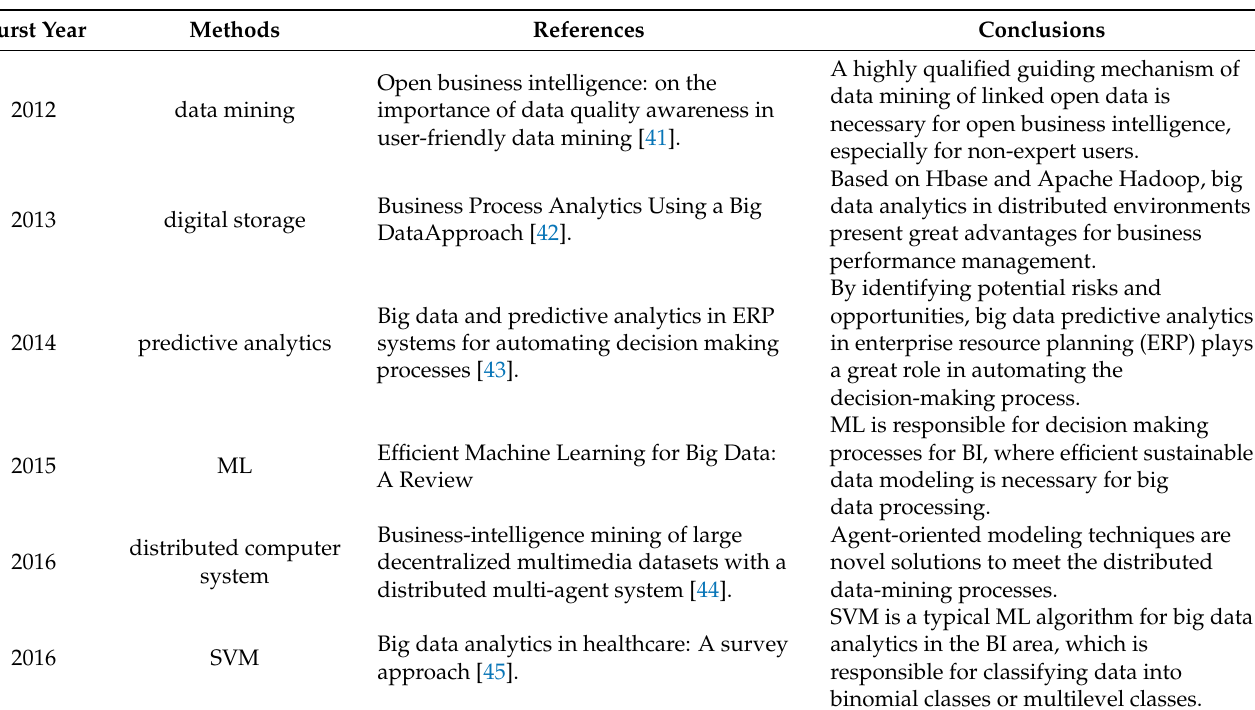
Table 8. Developing trend exploration of